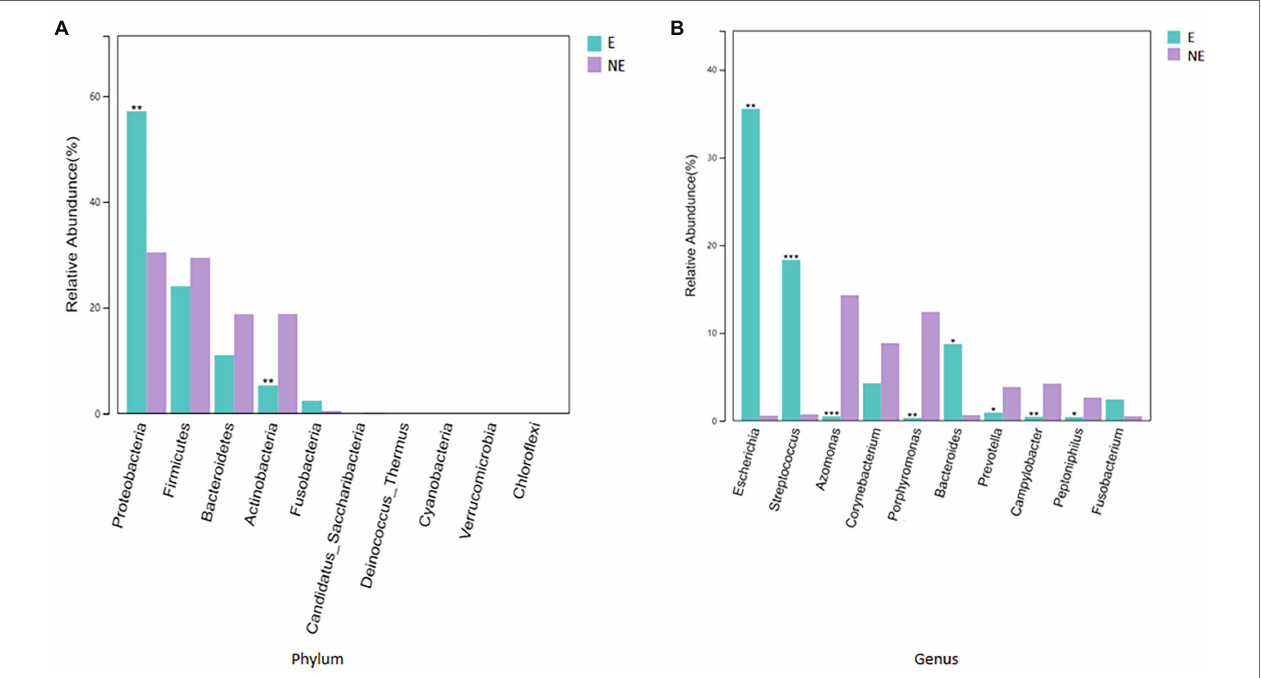
FIGURE 4 | (A) Comparison of bacterial differences among different groups of samples at the phylum level in top 10. (B) Comparative analysis of different species of bacteria among groups at genus level in top 10 ( p < 0.001, marked with “***”; 0.001 < = p < = 0.01, marked with “**”; 0.01 < p < = 0.05, marked with “*”; if p > 0.05, not marked).